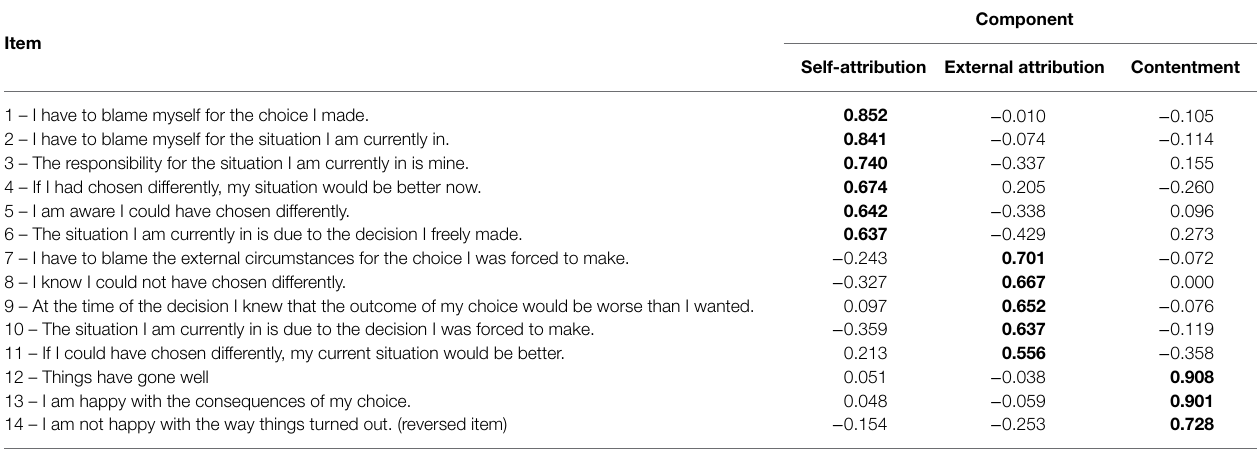
TABLE 4 | Study 2 – rotated component matrix of phenomenology